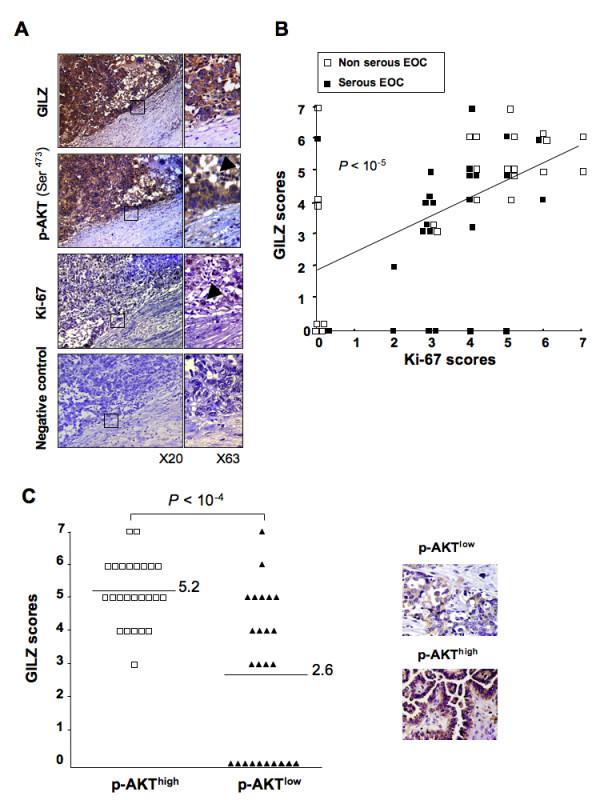
GILZ expression correlates with p-AKT levels and with cell proliferation in epithelial ovarian cancer (EOC). (A) Serial sections of tumors with staining for p-AKT, GILZ and Ki-67. Negative control was done without primary Ab. Original magnifications, ×20 and ×63. Pictures show cytoplasmic staining for GILZ and nuclear staining for Ki-67; p-AKT staining is mostly in the cytoplasm with some additional nuclear staining (arrow). (B) GILZ and Ki-67 final scores were positively correlated (Spearman test in univariate analysis, P < 0.00001, r = 0.56). (C) GILZ scores for p-AKThigh and p-AKTlow groups (the difference was significant at P < 0.05, Student's t test). Insets: high and low p-AKT immunoreactivity is shown on representative micrographs.